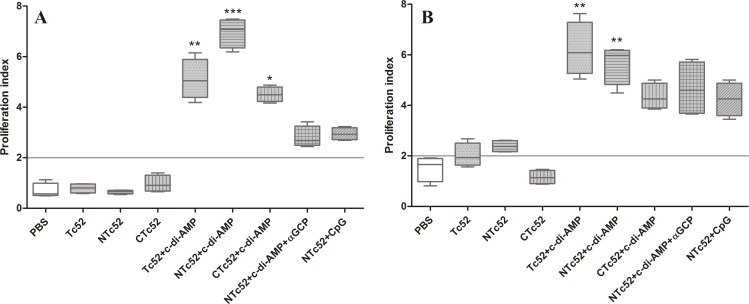
Cellular immune response against Tc52 in vaccinated mice.Lymph nodes and spleen were taken from each mouse 20 days after the last immunization. Proliferative responses are expressed as proliferation index (PI): a ratio of [3H]-thymidine incorporation (cpm) between cells stimulated with Tc52 and non-stimulated in A. lymph nodes cells, and B. spleen cells. Results are shown in box plots, line corresponds to median, boxes to 25th and 75th percentiles, and whiskers to minimum and maximum values. Results are representative of three independent experiments. *P < 0.05; **P < 0.01; ***P < 0.001.